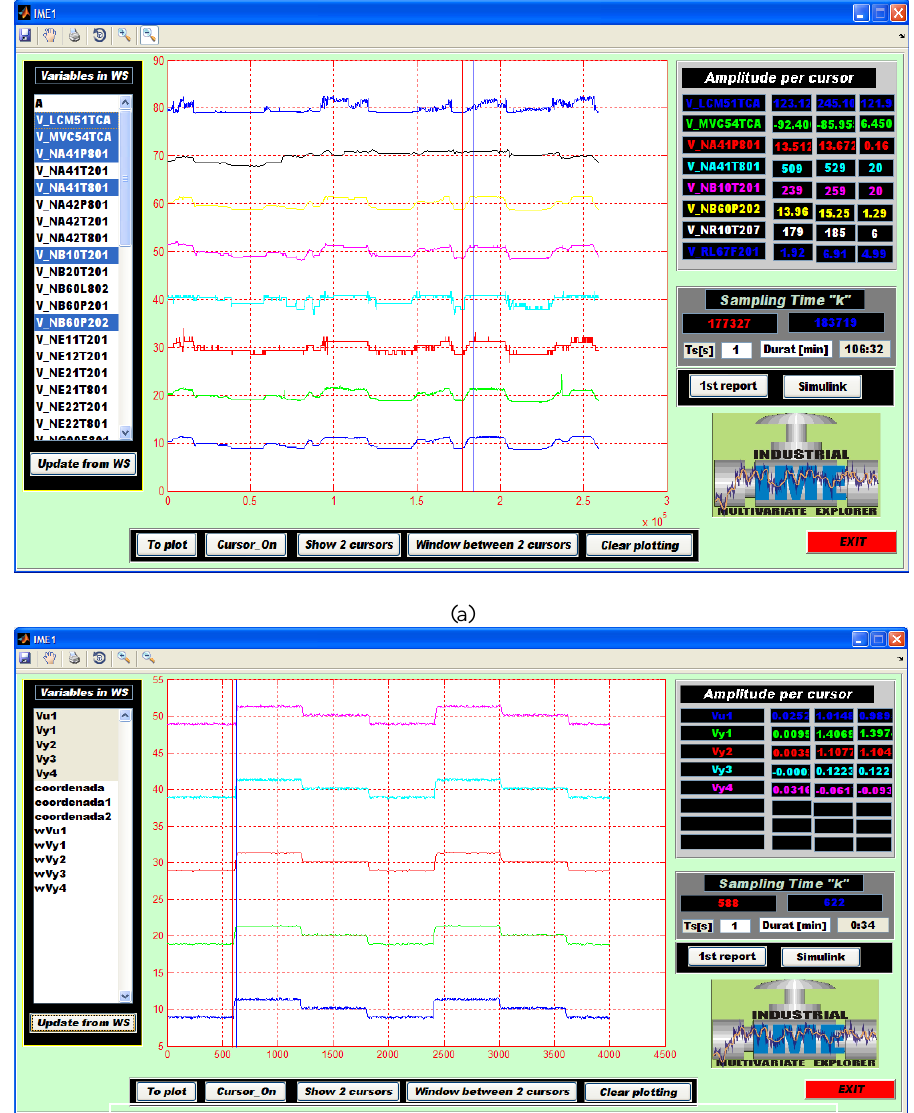
Figura 4. Prestaciones del Explorador Multivariado Industrial